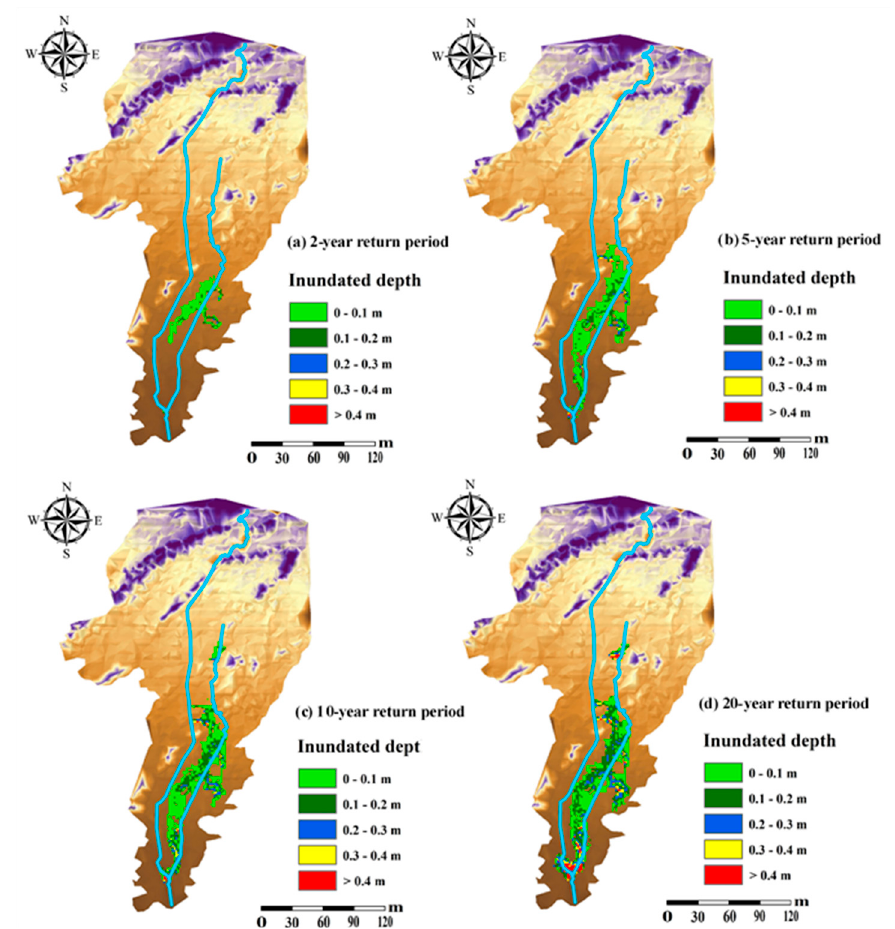
Figure 6. Flooding situation in the study area.